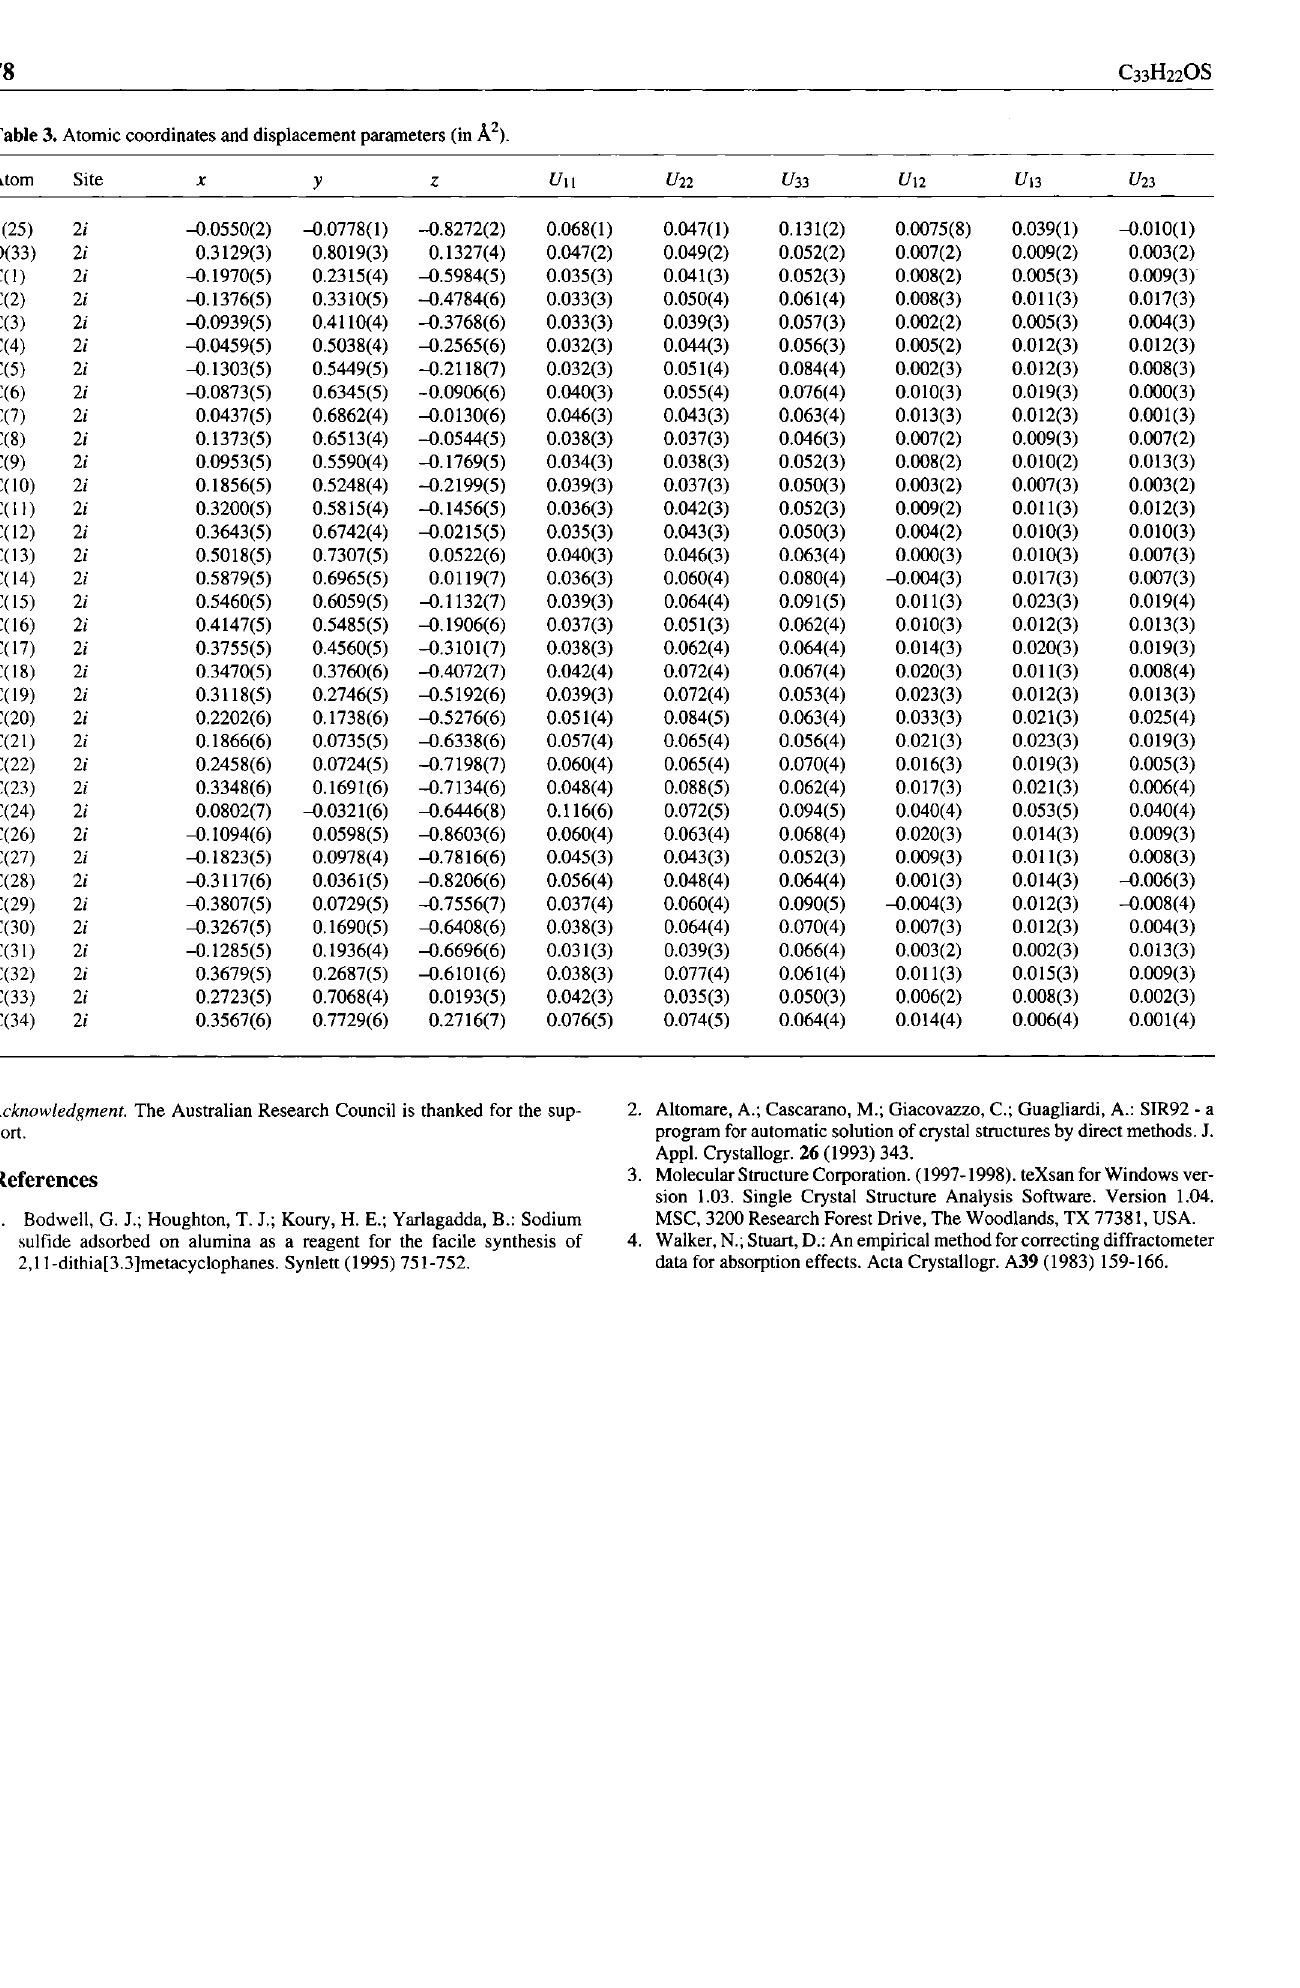
Table 3. Atomic coordinates and displacement parameters (in Ä 2